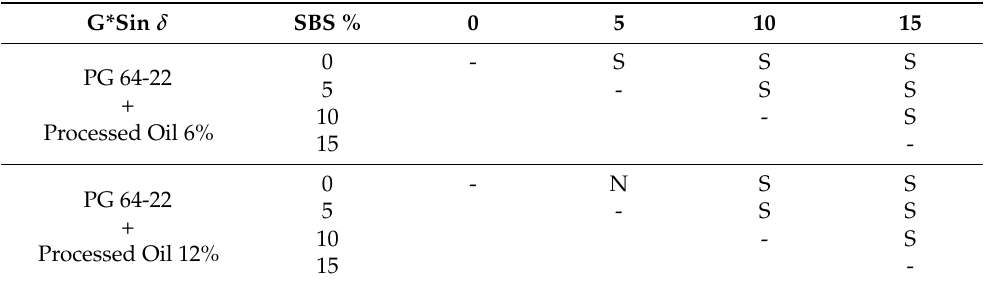
Table 10. Statistical analysis results of G*sin δ for RTFO + PAV aged PG 64-22 with processed oil as a function of SBS content ( α = 0.05).